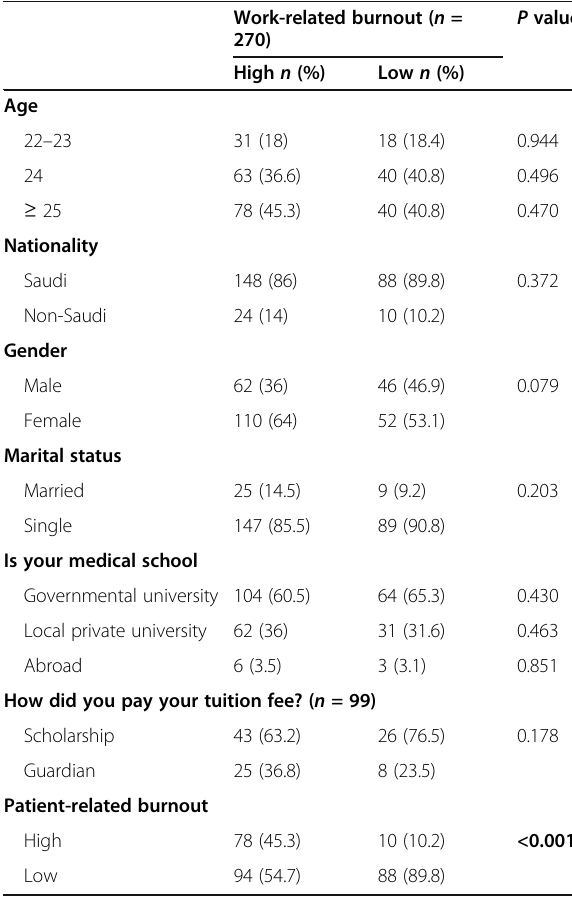
Table 5 Factors related to work-related